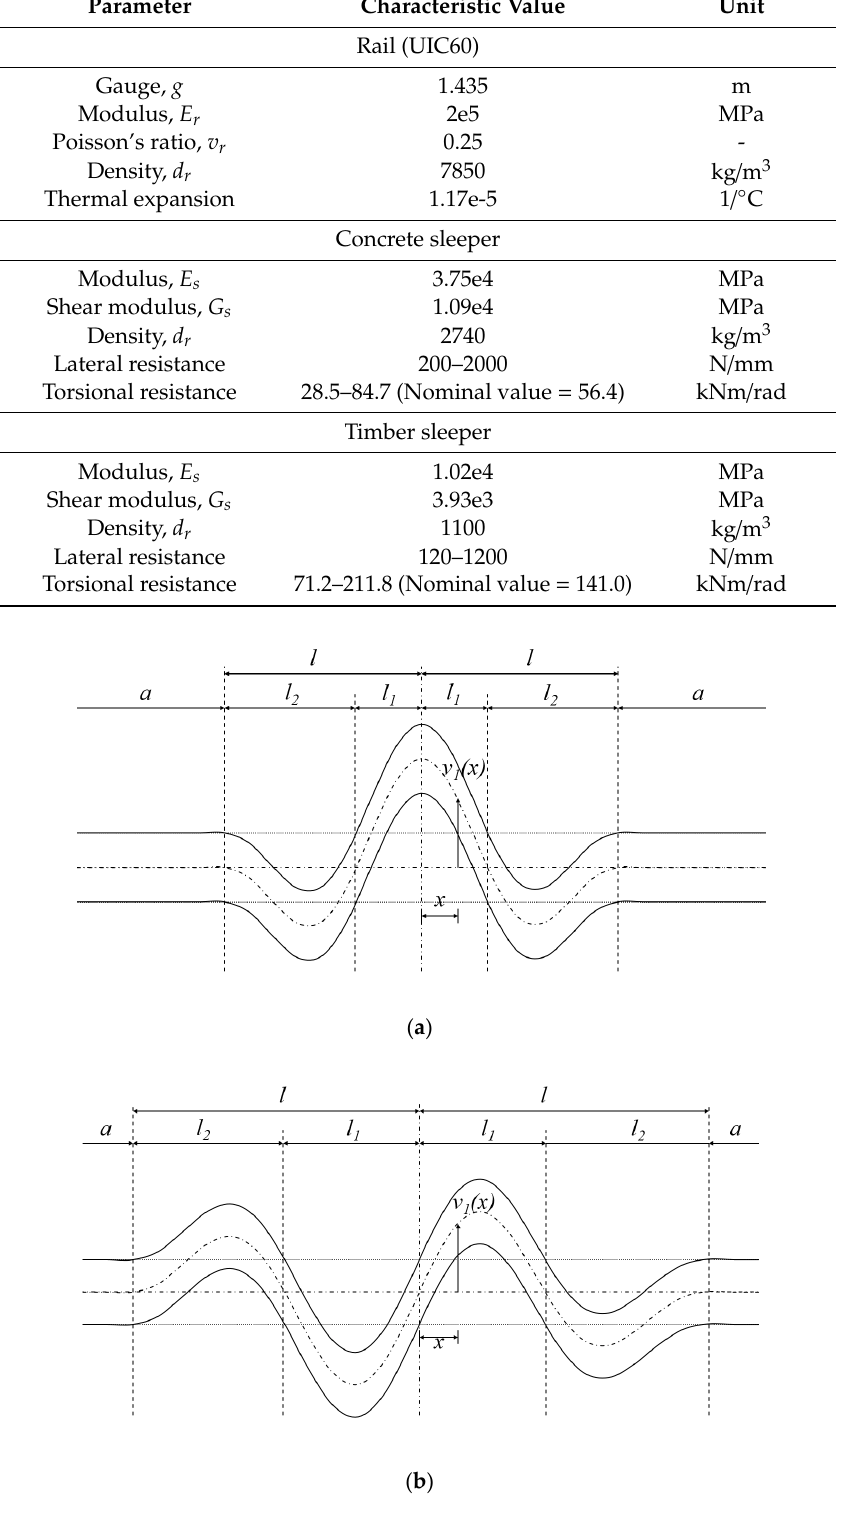
Figure 3. Typical buckling shape of the railway track and support constraints: ( a ) symmetrical and ( b ) antisymmetrical buckling shapes. ( b ) antisymmetrical buckling